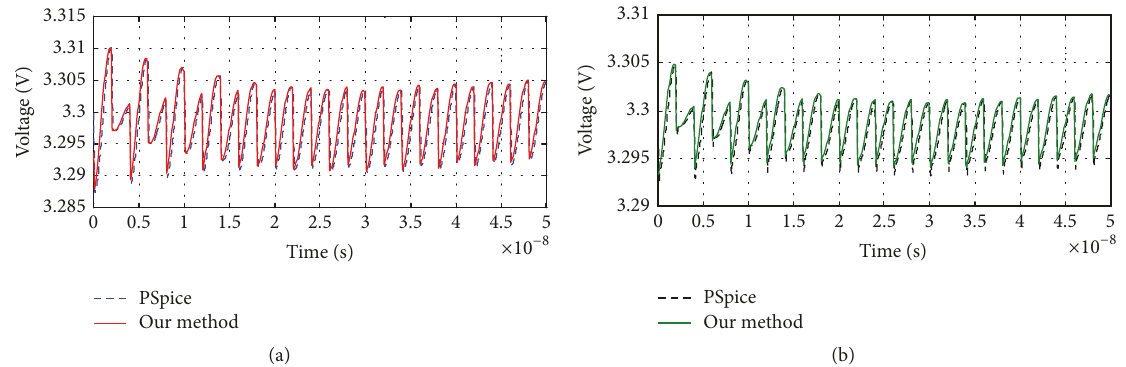
Figure 7: SSN waveform of the PDN near the first core; 𝐶